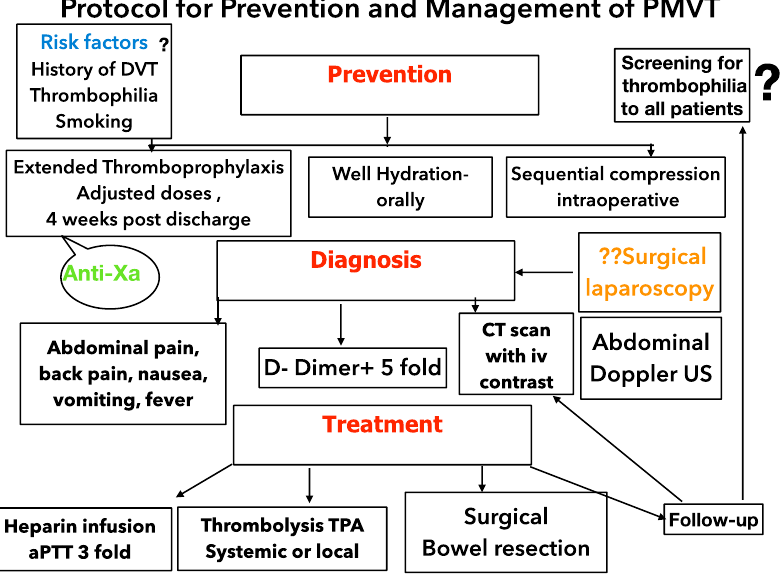
Figure 4. Protocol for prevention and management of PMVT in Ponderas Academic Hospital.